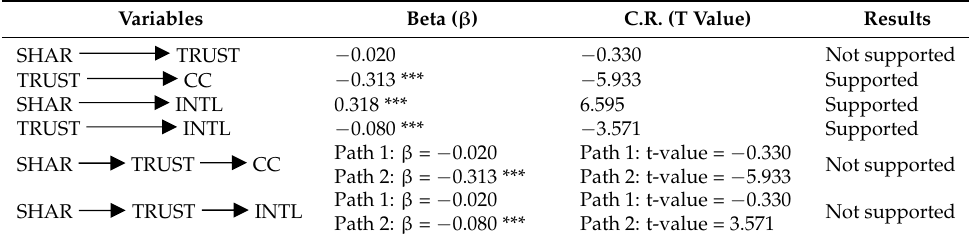
SHAR = Sexual Harassment by Superiors; Trust = Trust in Superiors; CC = Continuous Commit- ment; INTL = Intention to Leave; *** = p < 0.001.